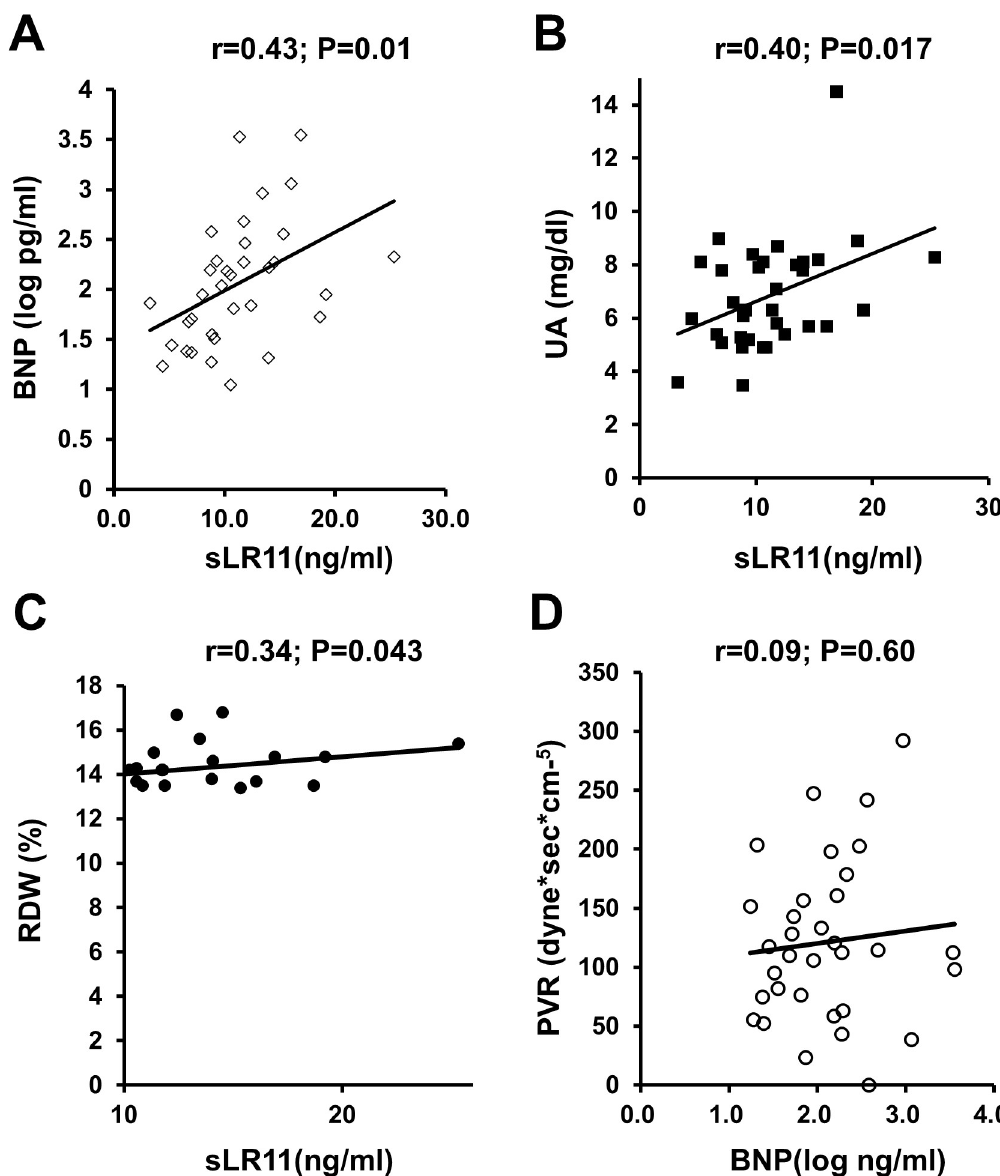
Fig 2. Associations between as known biomarkers of HF. A-C) Linear correlations of sLR11 with logBNP (A), UA (B), and RDW (C). D) No association is evident between logBNP and PVR. hypertension, dyslipidemia, and DM, sLR11 and logBNP. Analyses revealed that mPAP was associated with higher levels of sLR11 (B = 0.75 mmol/L, 95% confidence interval [CI] = 0.12– 1.39 mmol/L; p = 0.02) and logBNP (B = 7.54 log ng/ml, 95%CI = 2.61–12.5 log ng/ml; p = 0.004) (Table 2). Levels of sLR11 offered a significant predictor of mPAP, similar to logBNP. Based on our previous normal human sLR11 level of 7.8 ± 1.6 ng/mL, we established an upper limit of normal for sLR11 of 9.4 ng/ml. The cutoff of 9.4 ng/ml was used to define the normal-sLR11 group (sLR11 � 9.4 ng/ml) and the high-sLR11 group (sLR11 > 9.4 ng/ml). Details of these two groups are shown in Table 3. Patients in the high-sLR11 group showed sig- nificantly higher mPAP and PVR and significantly lower LVEF than the normal-sLR11 group.